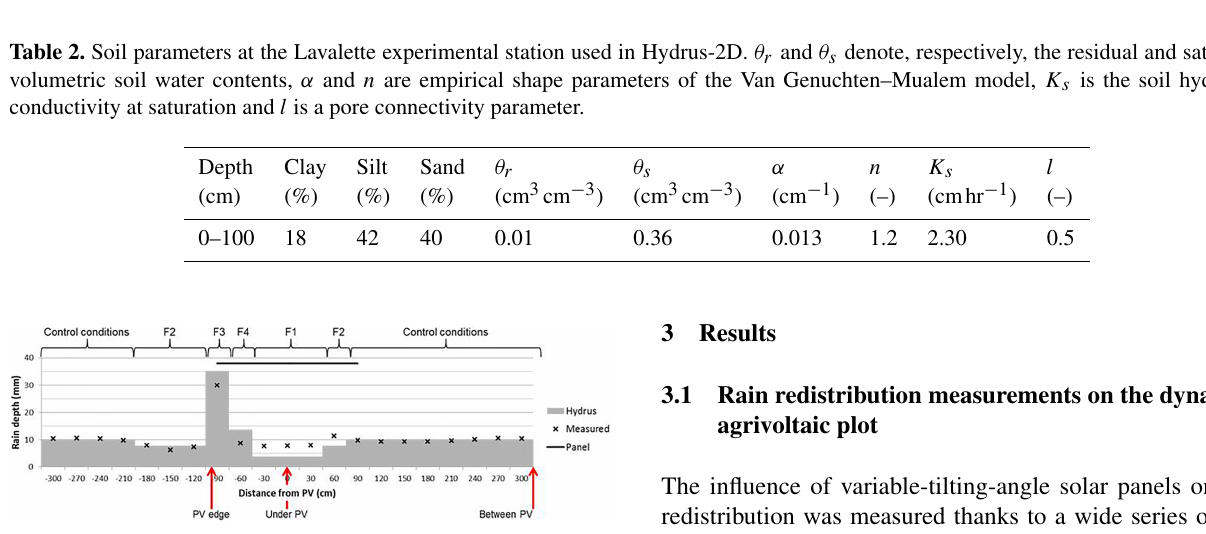
Figure 5. Time-variable upper boundary conditions used in Hydrus- 2D for the tested rain event, during which the tilting angle of the panels was varied to minimize rain interception (avoidance strat-